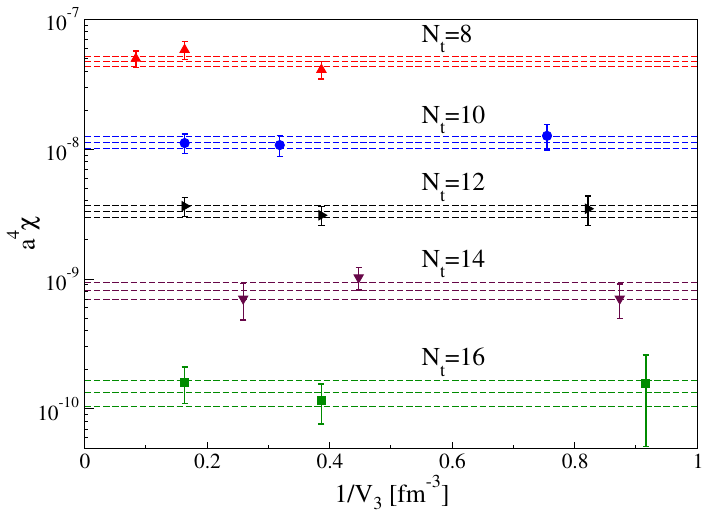
Figure 8 . Topological susceptibility in lattice spacing units, as a function of the inverse spatial